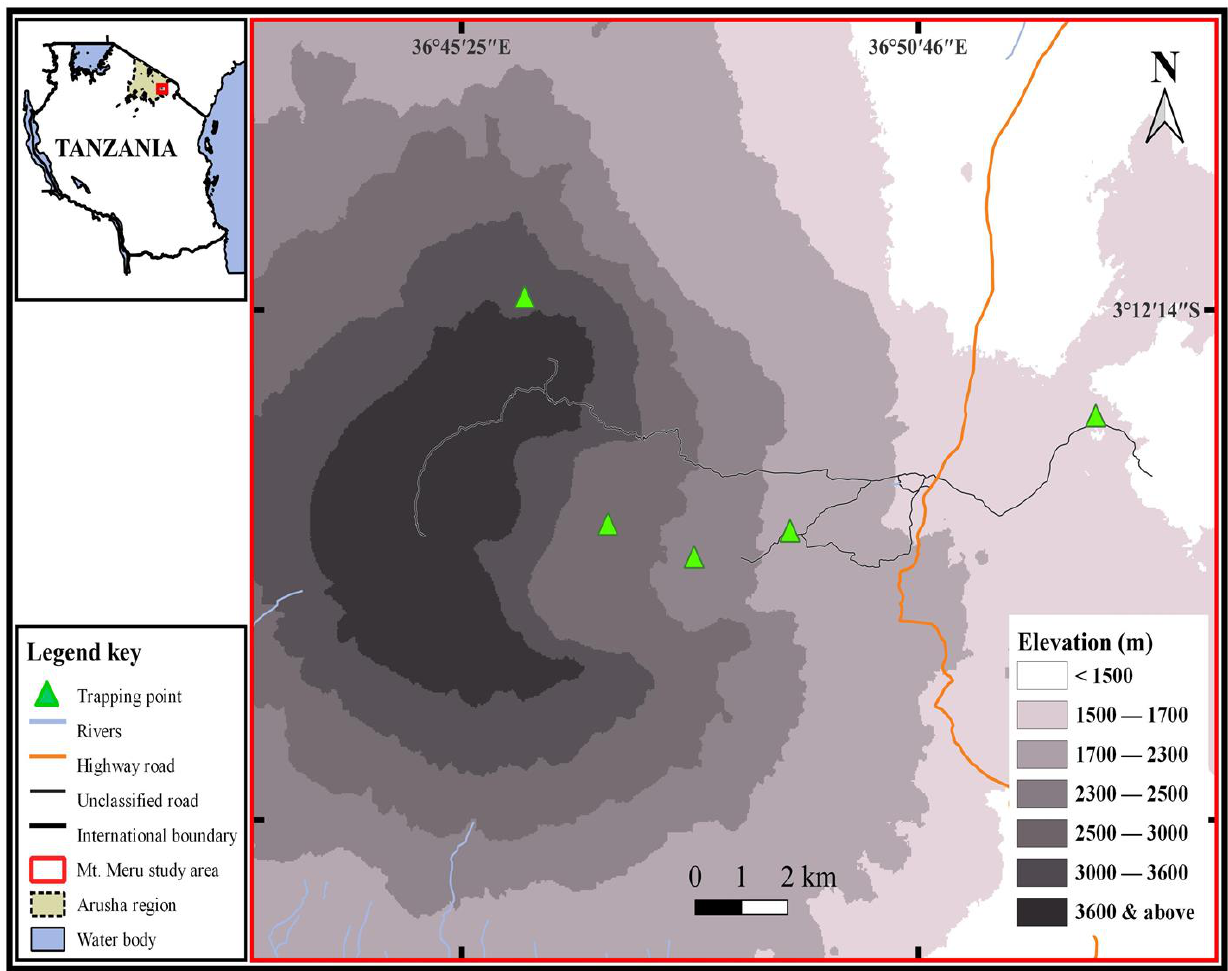
Figure 1. Geographic locations of trapping sites on Mount Meru.